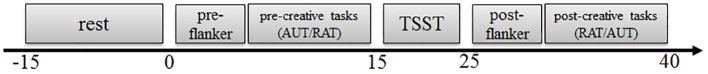
Schematic illustration of the procedure. Saliva from the participants was collected at five time points (−15, 0, 15, 25, and 40 min in relation to the onset of the stressful task). After a rest phase, participants performed Flanker task and creative tasks (AUT and RAT) before and after the TSST.